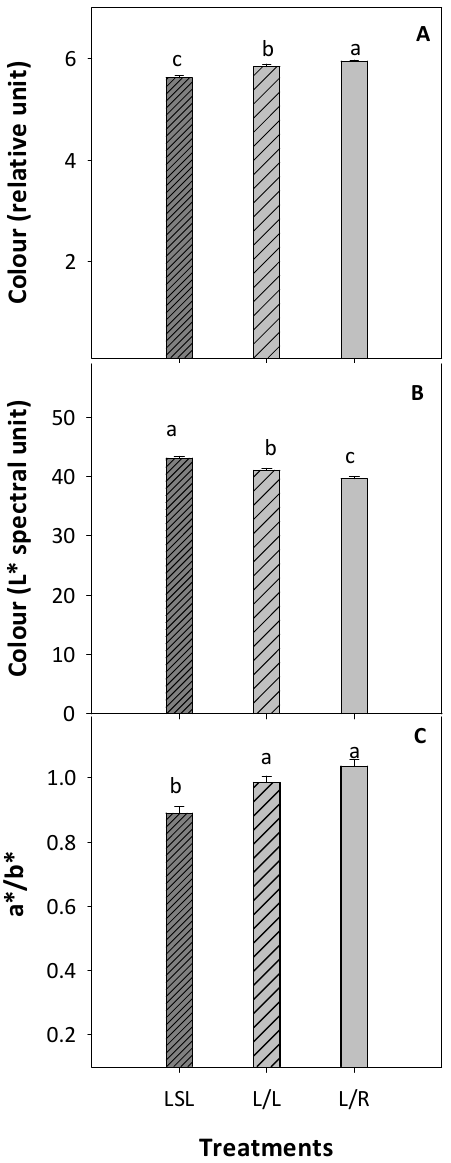
Figure 6. Fruit visual color ( A ) (method USDA units), fruit spectral color parameters L * ( B ) (spectral units) and fruit level of redness a*/b* ( C ) by treatments LSL (long-shelf-life tomato), L/L (self-grafted Old Limachino tomato) and L/R (grafted Old Limachino tomato on Poncho Negro rootstock) under greenhouse conditions. Each value represents the mean ± SE ( n = 12). Lower-case letters indicate differences ( p ≤ 0.05, Duncan test) among treatments.